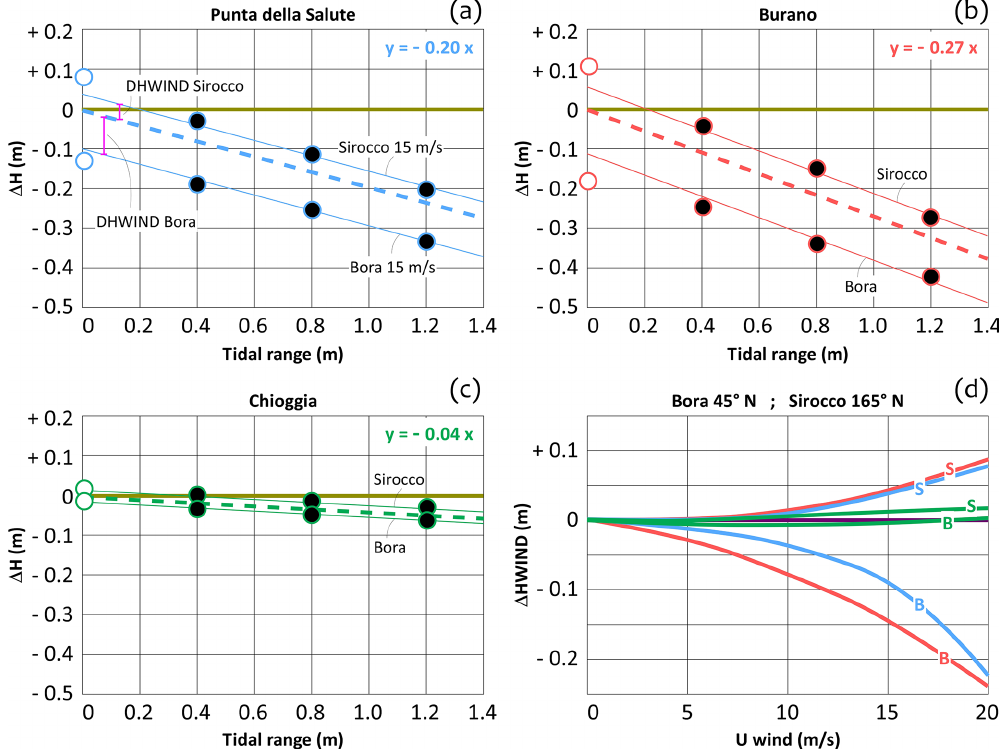
Figure 4. Synthetic sinusoidal tide, tidal period of 6h, PCL. (cid:49)H variation in the case of wind ( (cid:49)H WIND ). (a) Punta della Salute; (b) Burano; (c) Chioggia. Dashed lines refer to the relationship obtained with no wind (scenario I, Fig. 3) and solid thin lines to scenario (II), with Sirocco and Bora winds of 15ms − 1 . White bullets refer to the simulations performed with no tide. (d) (cid:49)H variation with respect to the no wind condition ( (cid:49)H WIND ) computed at PS (blue lines), Burano (red), and Chioggia (green), ranging the speeds of Bora and Sirocco from 0 to 20ms − 1